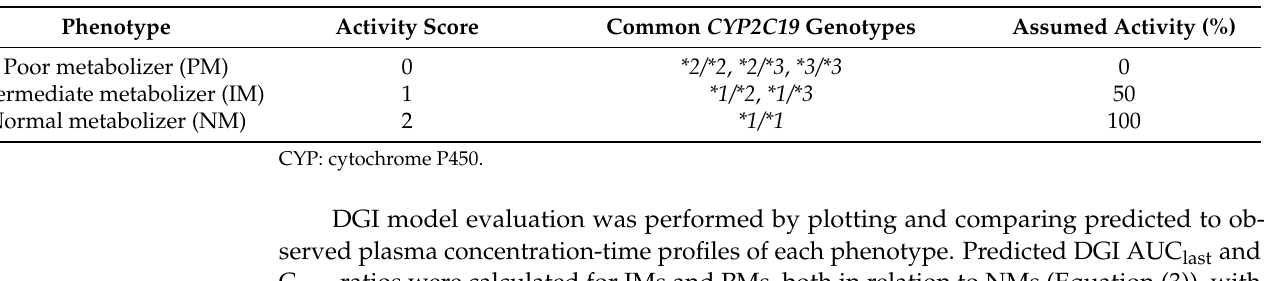
Table 1. Relation between CYP2C19 phenotypes, activity scores, and genotypes according to [74], including assumed relative